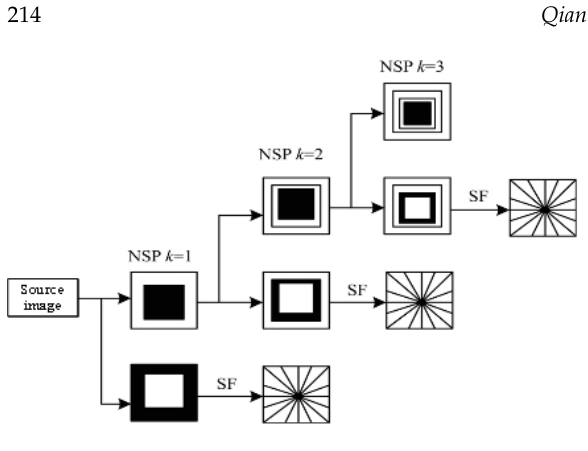
Fig. 1. NSST multi-scale and multi-direction decomposition